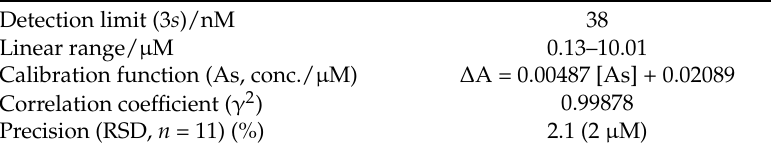
Table 1. Analytical figures of merit of the proposed AuNRs colorimetric probe for As(III).